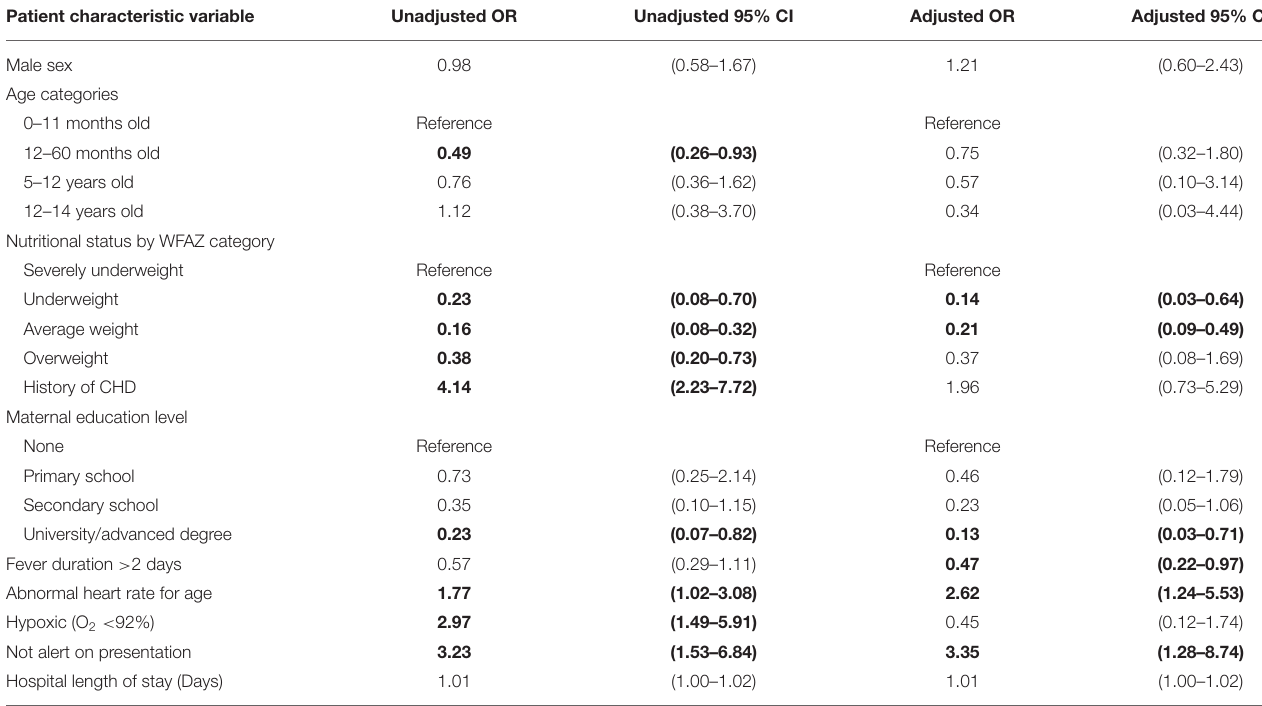
TABLE 4 | Multivariable logistic regression model results: unadjusted and adjusted odds of decline in functional status. Patient characteristic